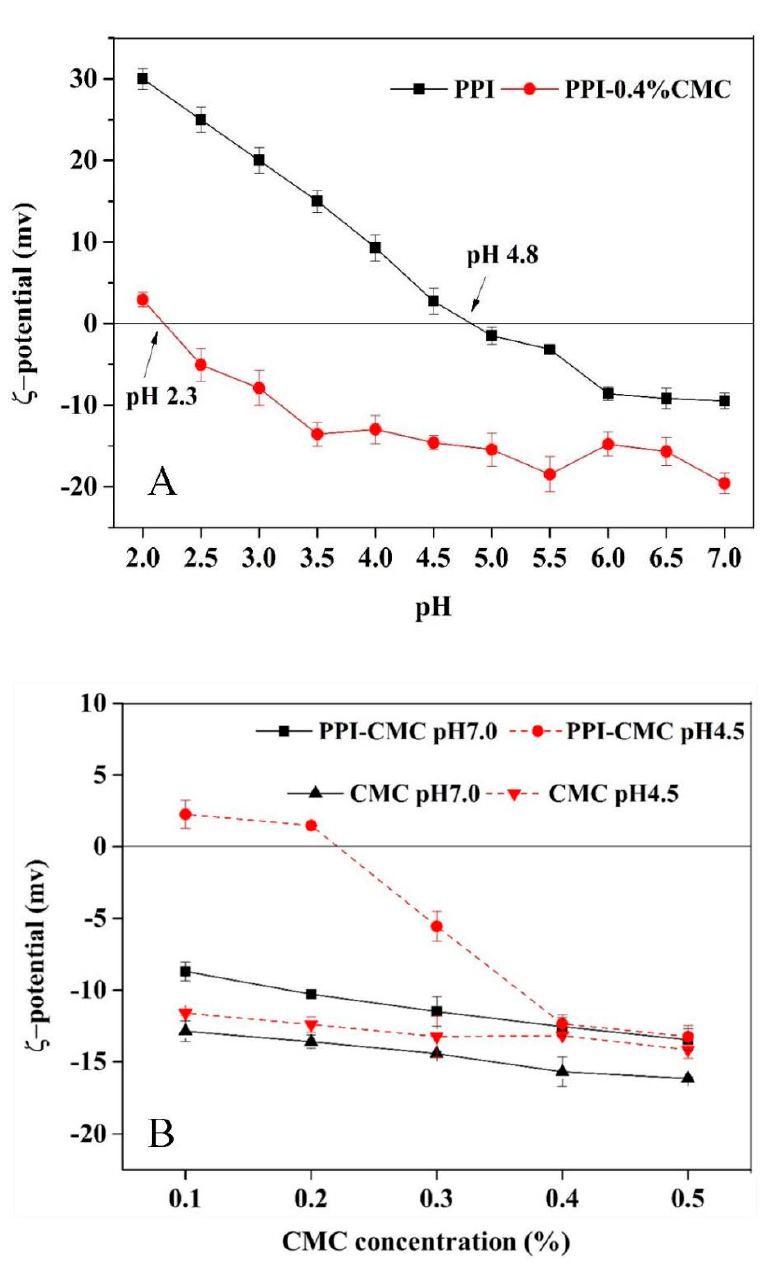
Figure 4. The pH-dependence of ζ -potential for PPI or CMC solutions ( A ) and the effects of CMC concentrations on the ζ -potential of 3.0% PPI solution at pH 7.0 and 4.5 ( B